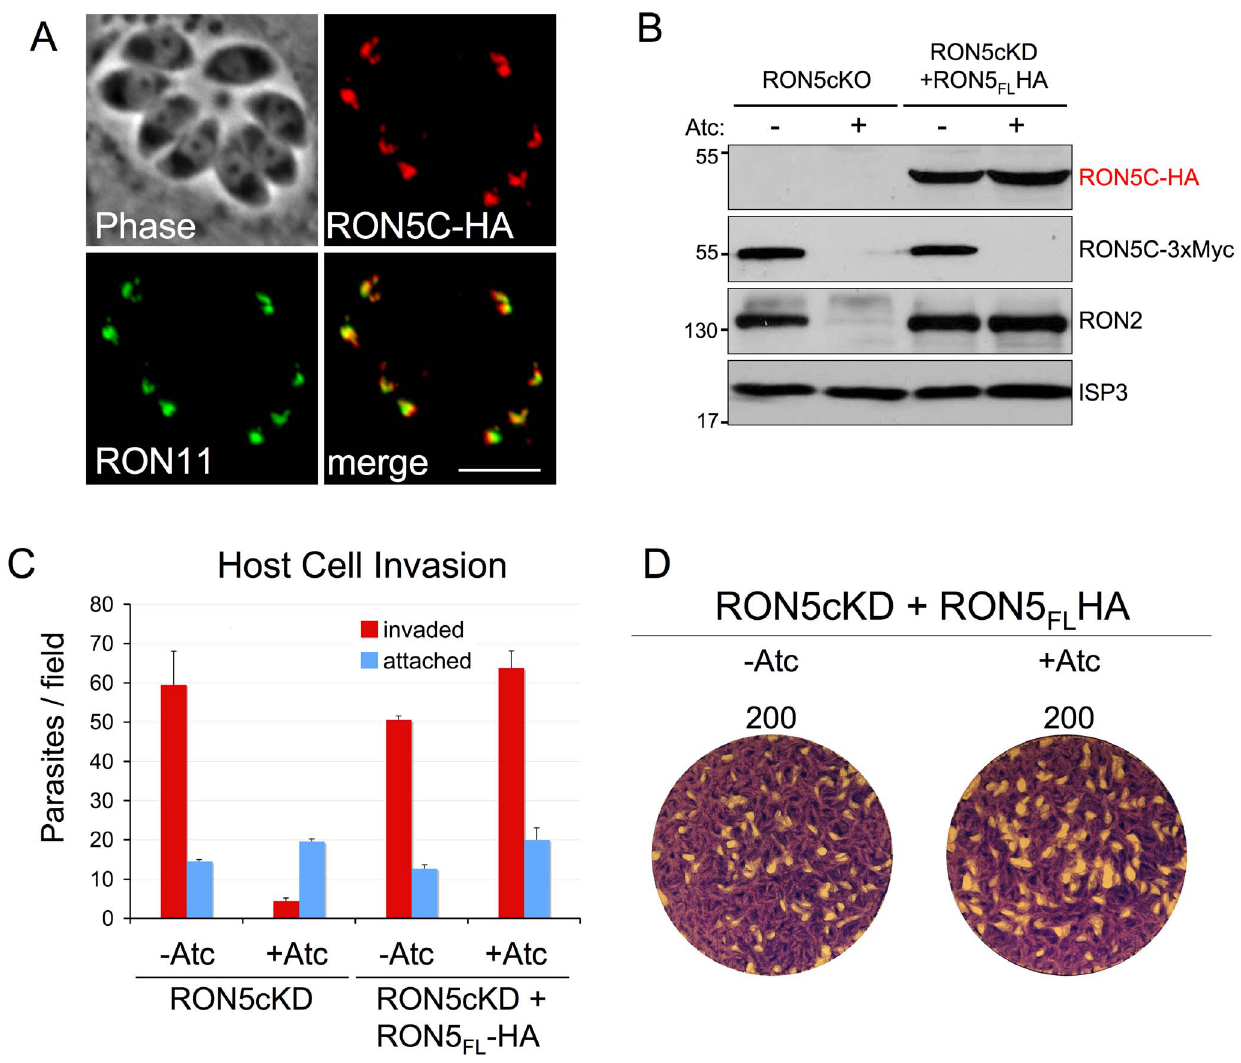
Figure 5. Establishment of a RON5cKD functional complementation system. (A) IFA showing rhoptry neck targeting of a second copy of RON5 with a C-terminal HA tag. RON5-HA targets properly to the rhoptry neck, as assessed by co-localization with RON11. Red: rabbit anti-HA antibody detected by Alexa594-anti-rabbit IgG. Green: rat anti-RON11 antibody detected by Alexa488-anti-rat IgG. Scale bar=5 m m. (B) Western blot showing rescue of RON2 stability in Atc treated RON5 MYC cKD by stable expression of a second copy of RON5. Expression of an HA tagged second copy of RON5 is unaffected by Atc treatment while expression of the endogenous, MYC-tagged copy of RON5 under the control of the tet-regulatable promoter is eliminated. While repression of endogenous RON5 results in degradation of RON2, expression of the complementing RON5 second copy fully rescues RON2 stability. ISP3 serves as a loading control. A complete rescue of (C) invasion and (D) restored plaque formation is also observed in RON5 MYC cKD parasites complemented with a second copy of RON5.